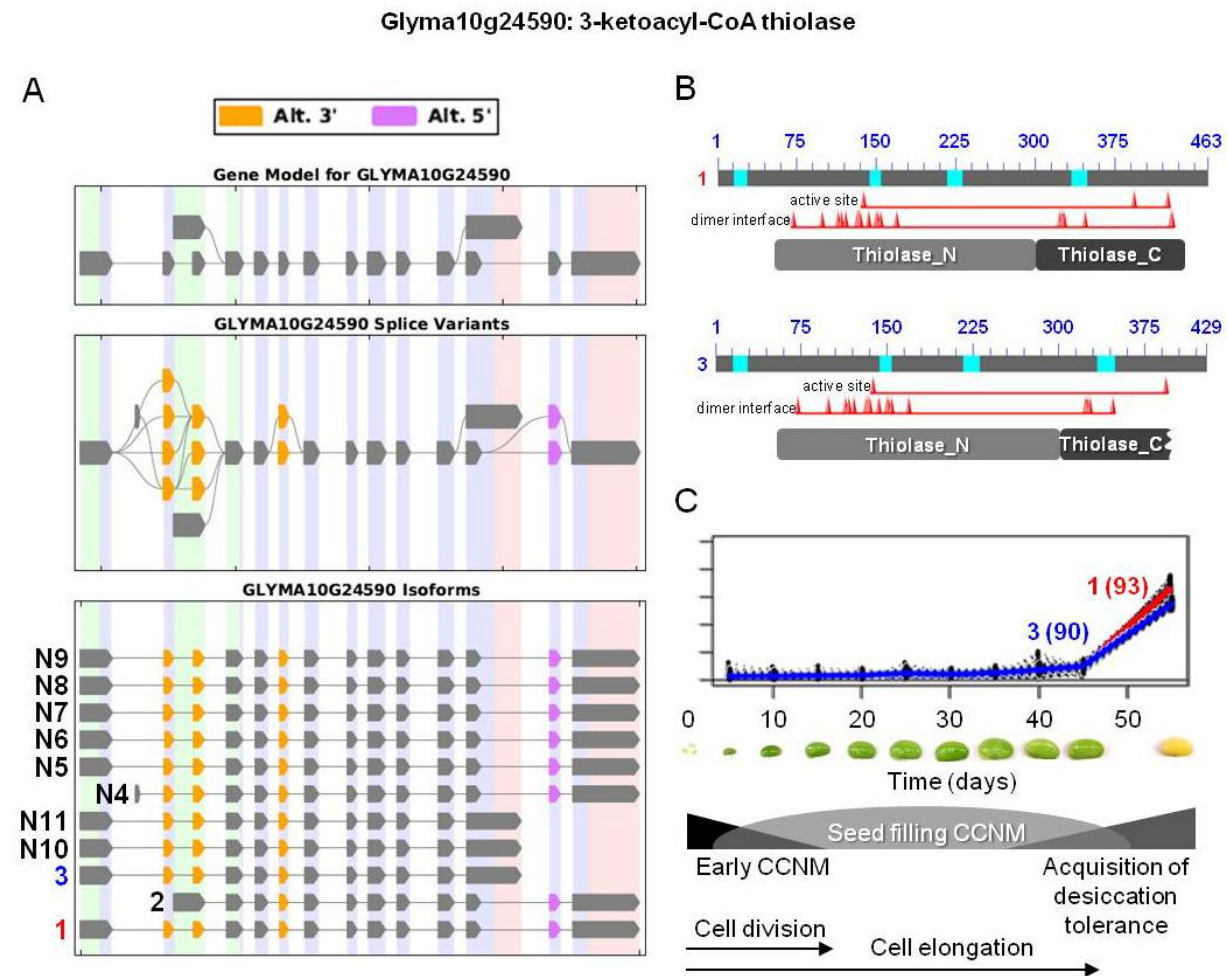
Figure 5. AS of 3-ketoacyl-CoA thiolase involved in fatty acid degradation during late maturation stages of soybean embryo development. ( A ) SpliceGrapher representations of individual isoforms detected during soybean embryo development. Alternative 3' and/or 5' splicing of many novel isoforms were identified. Glyma10g24590.1 and 3 correspond to 1 and 3 and were the only two transcripts displaying differential expression. ( B ) Proteins resulting from two isoforms of interest with the respective positions of active and dimer interface sites in the N - and C -terminal thiolase domains (pfam00108 and pfam02803, respectively), showing the positions of individual amino acid residues (red triangles). Bright blue sections of the protein show the sequences that were not included in domain analysis due to an amino acid composition-related bias. ( C ) Overlaid expression profiles of Glyma10g24590.1 and 3 obtained from